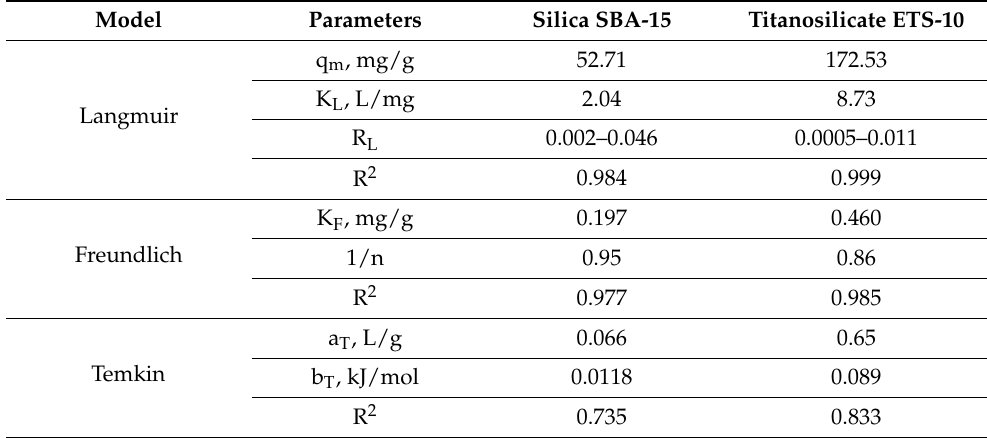
Table 1. Langmuir, Freundlich and Temkin isotherm parameters for the sorption of Cu(II) on silica SBA-15 and titanosilicate ETS-10 adsorbents.